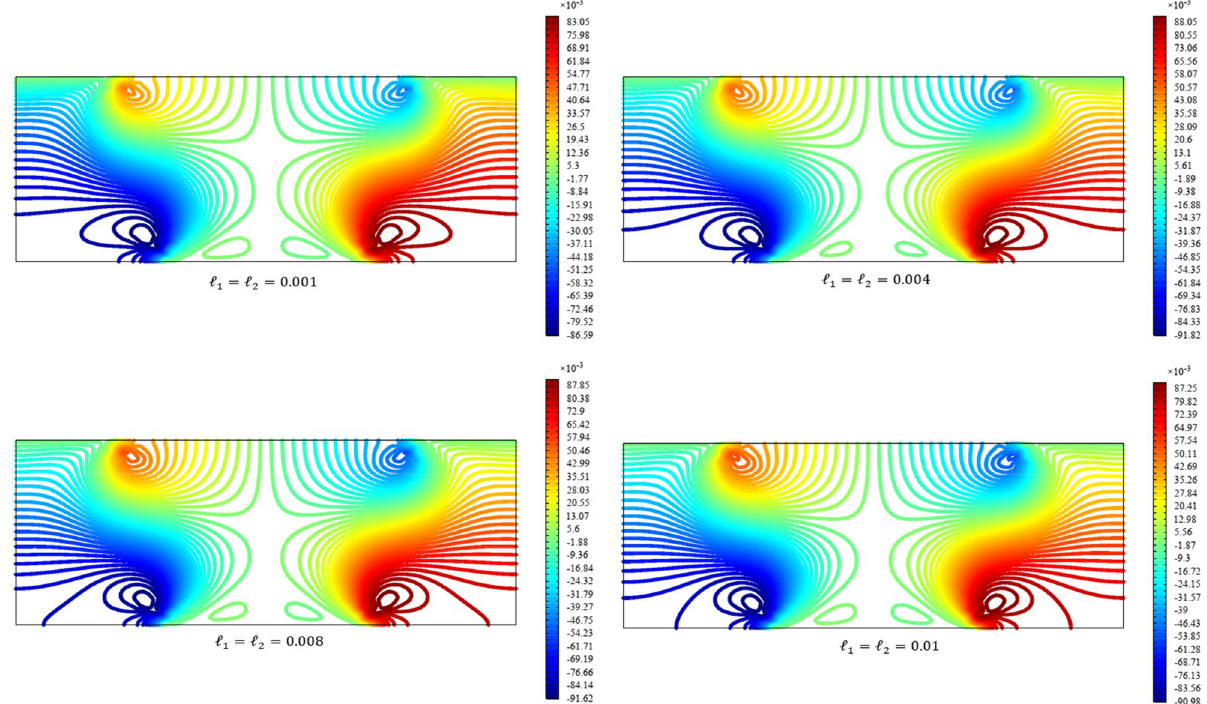
/ | u 0 | for different values of ℓ 1 and ℓ 2 (COMSOL x , y (cid:31) (cid:30)